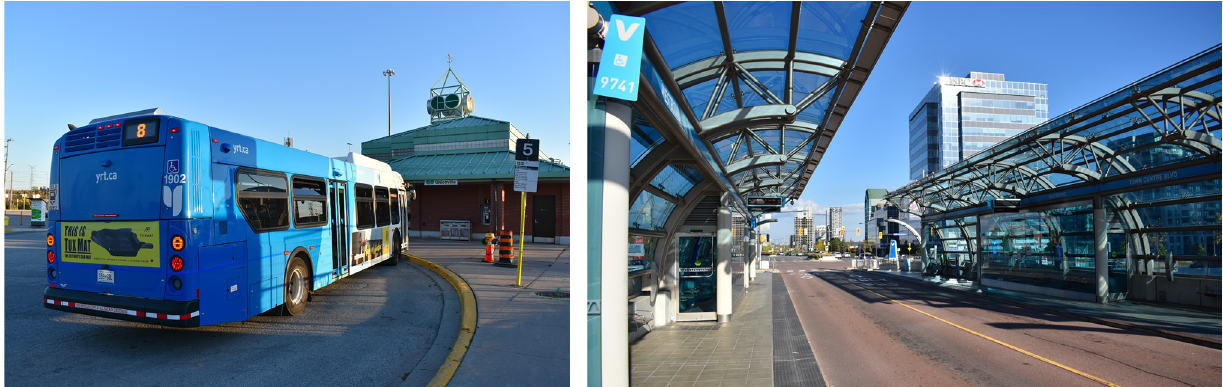
Figure 6. Left: York Region Transit bus at the GO train station. Right: Bus rapid transitway station on Highway 7. Source: